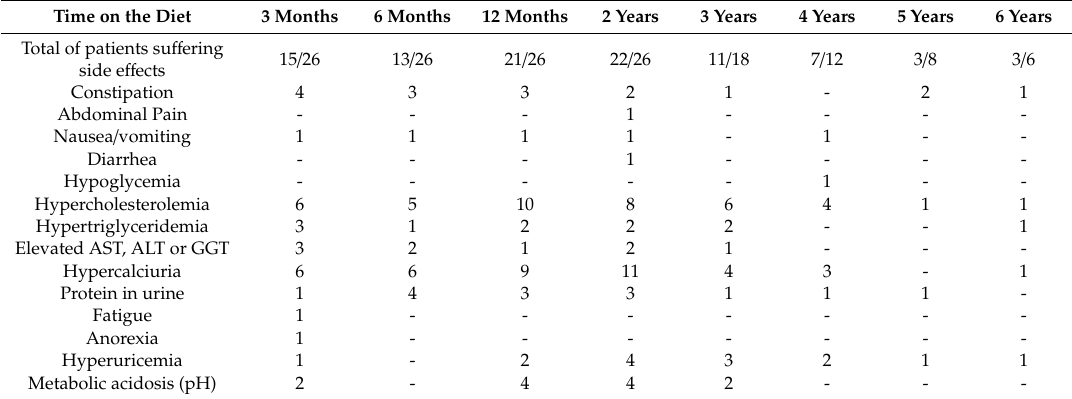
Table 4. Number of patients who su ff er from late side e ff ects of the KD at every evaluation period. Time on the Diet 3 Months Total of patients su ff ering side e ff